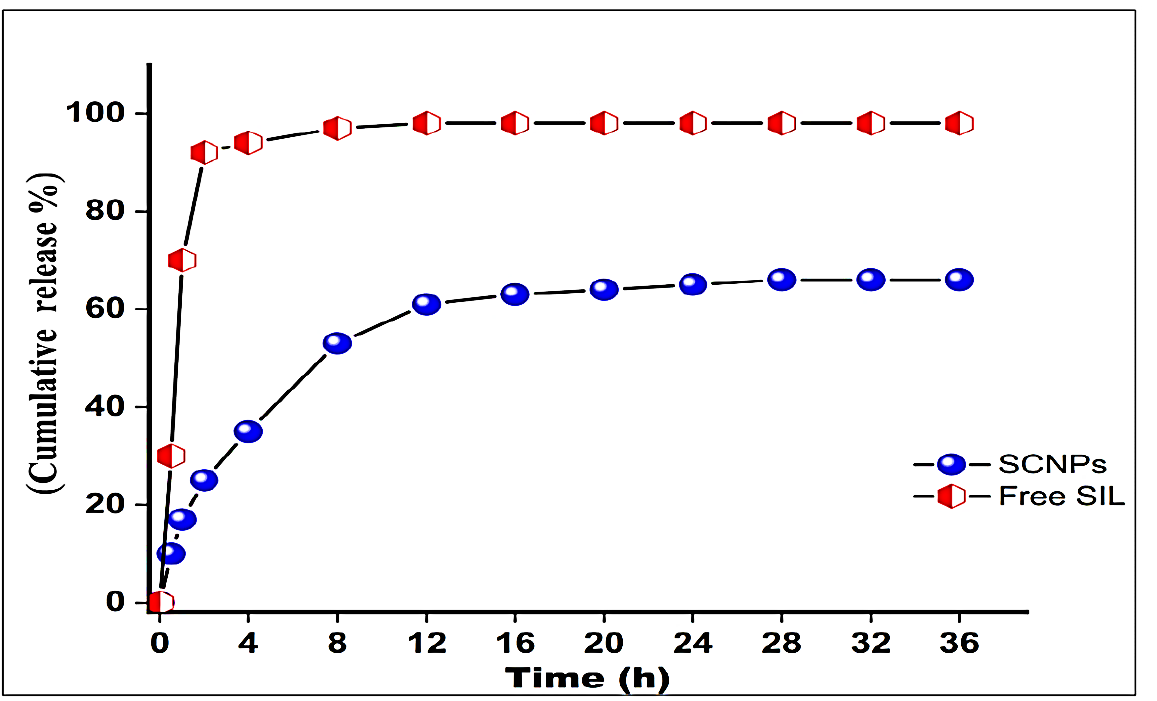
Figure 4. Cumulative in vitro release profile of free SIL from SCNPs. Each data point is represented as mean ± SD ( n = 3).